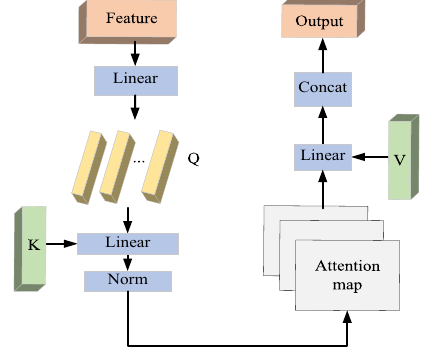
Figure 2. The architecture of external aention block .